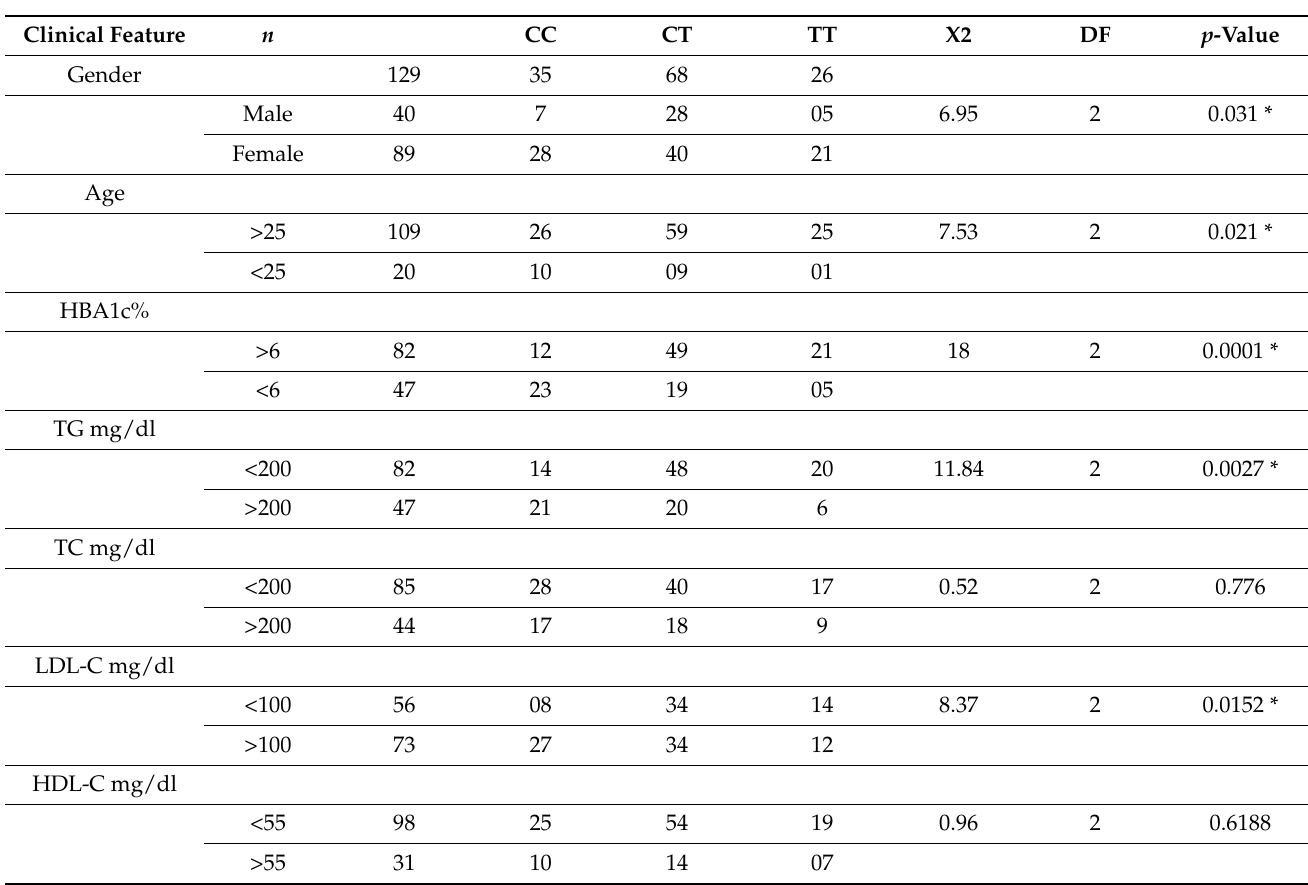
Table 13. Association of miR128 rs11888095 C/T genotypes with T2D patients’